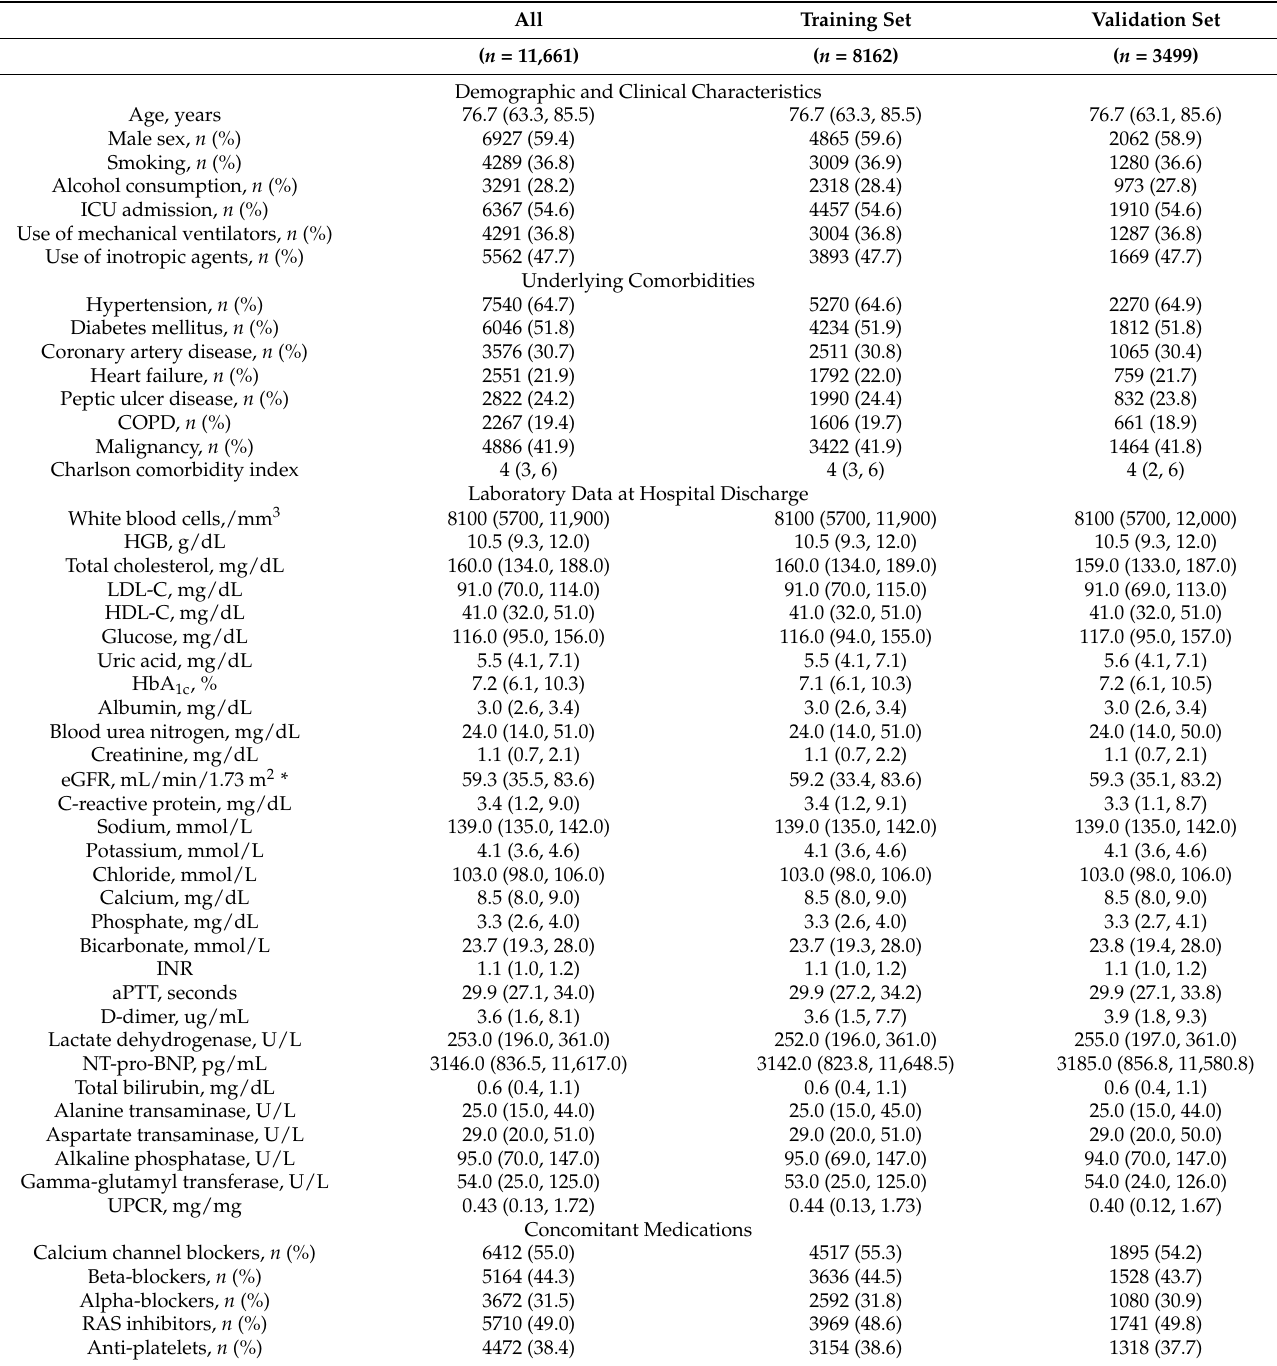
Table 1. Clinical features of the patients in the training and validation sets used in machine learn- ing models. All Training